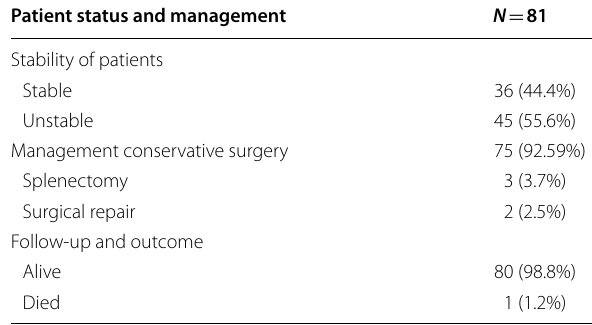
Table 7 Associated chest injury in the current study